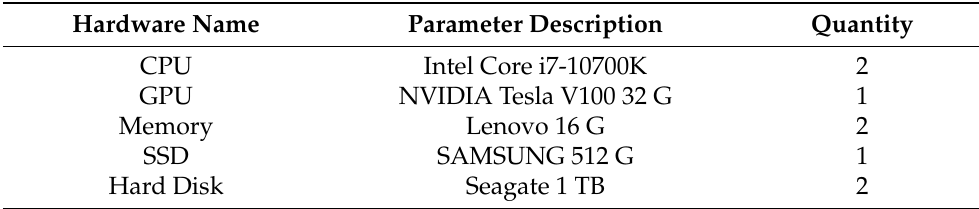
Table 2. Hardware